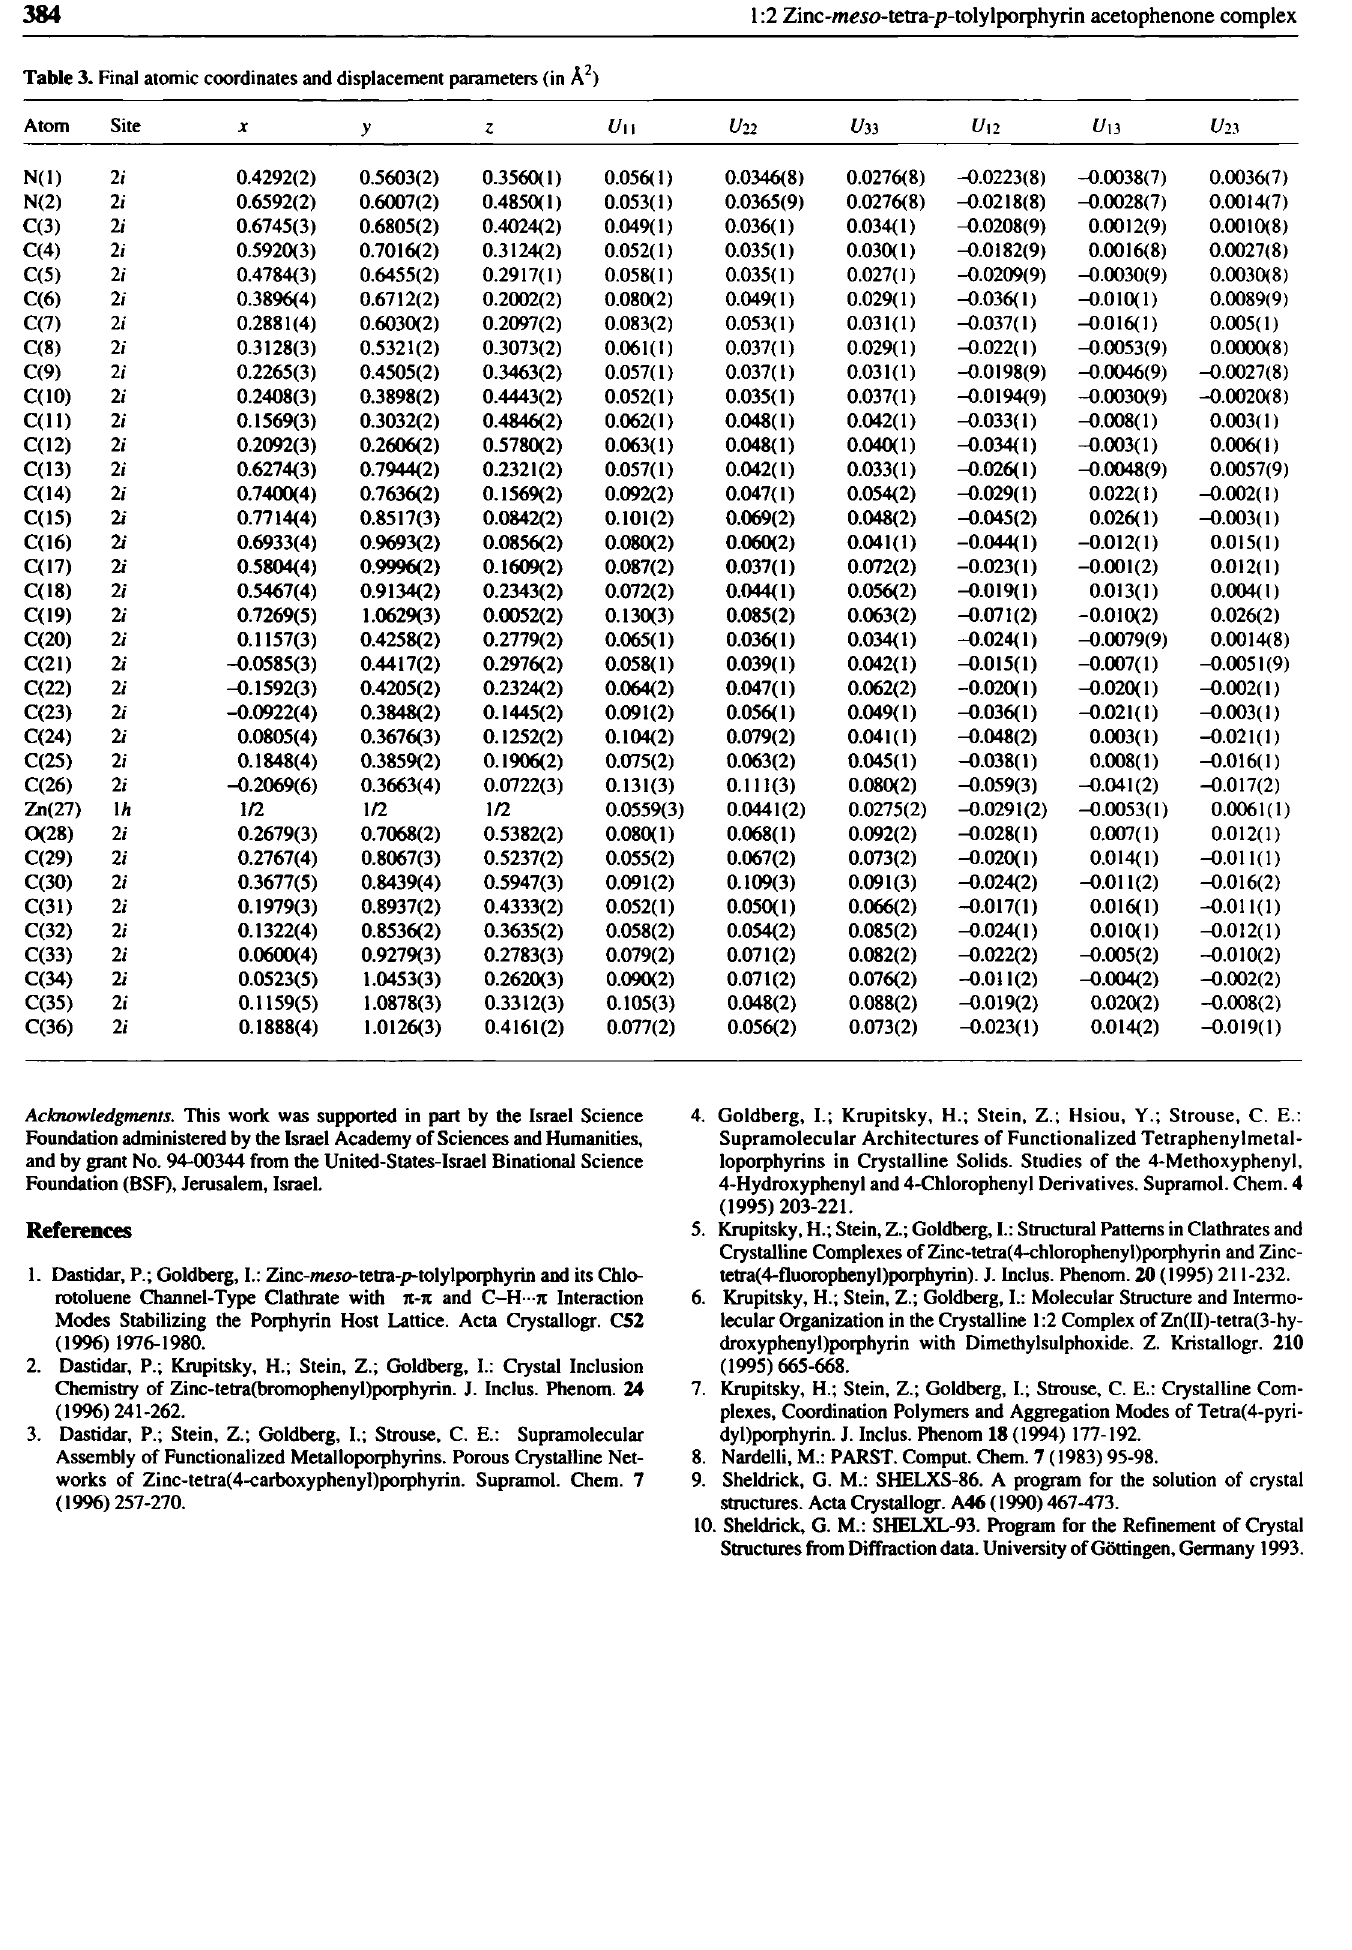
Table 3. Final atomic coordinates and displacement parameters (in Â 2